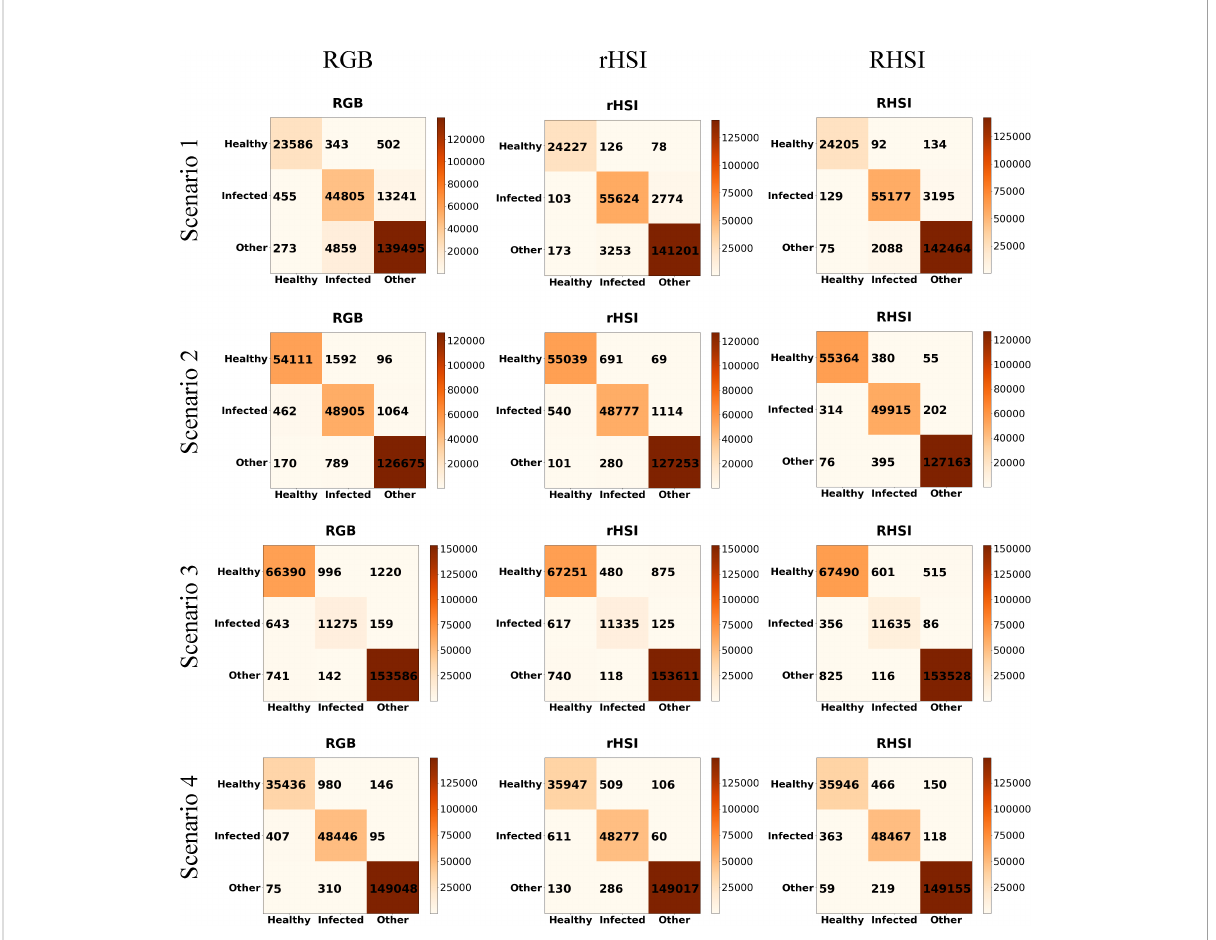
FIGURE 7 Confusion matrices of all scenarios. (In each confusion matrix, the abscissa axis represents predicted class and the ordinate axis represents actual